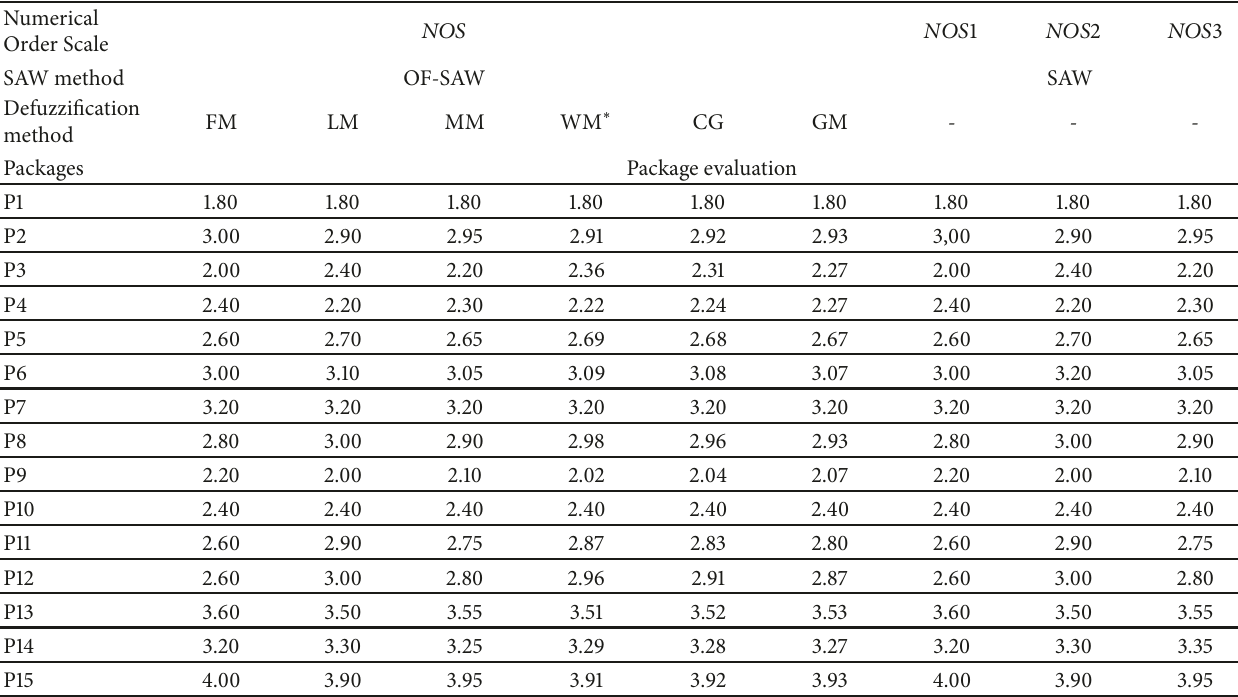
Table 6: Package evaluations obtained by SAW methods.